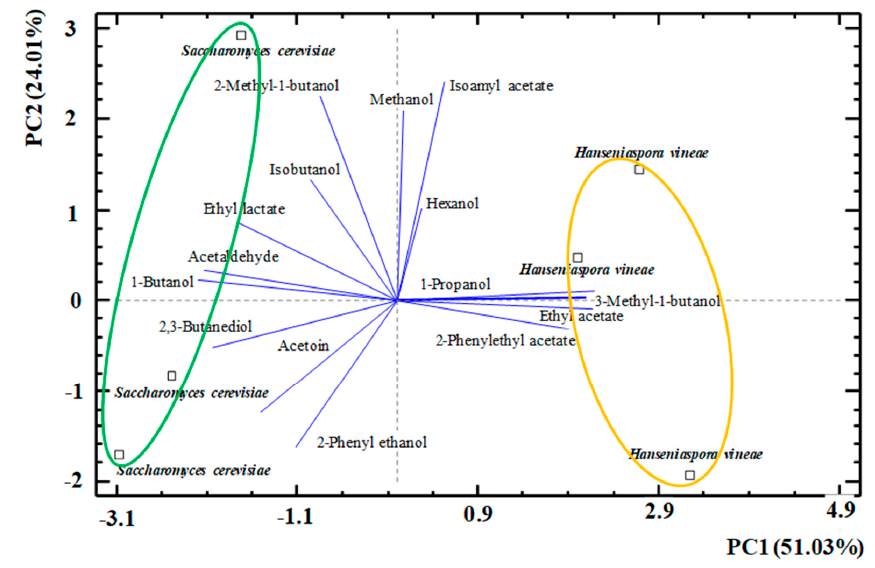
Figure 2. Principal component analysis (PCA) of the fermentative volatile